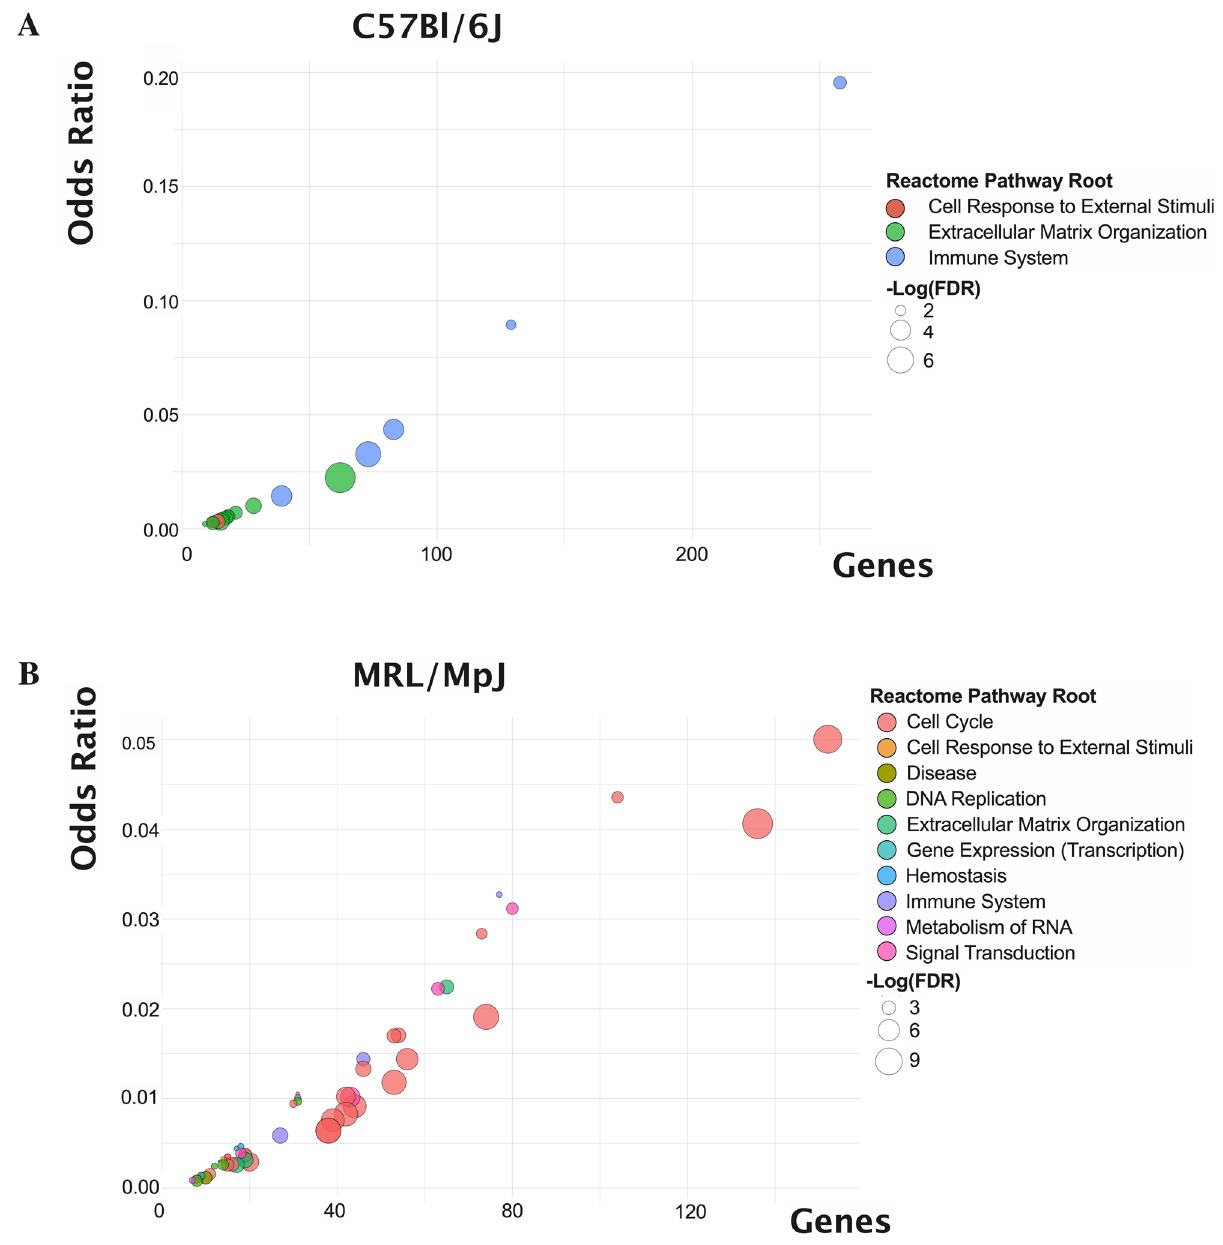
Figure 4. Functional annotation based on Reactome Pathways enrichment of 891 and 1358 differentially expressed genes (DEG) at 7 days post tendon injury in the C57 and MRL mice, respectively. Bubble plots of number of gene terms (x-axis) versus odds ratio (y-axis) represent 22 significantly enriched pathways in the injured C57 tendon ( A ) and 51 significantly enriched pathways in the injured MRL tendon ( B ) based on False Discovery Rate (FDR) <